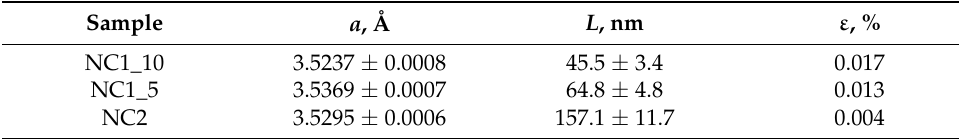
Table 3. Microstructural parameters of polycrystalline Ni phase.